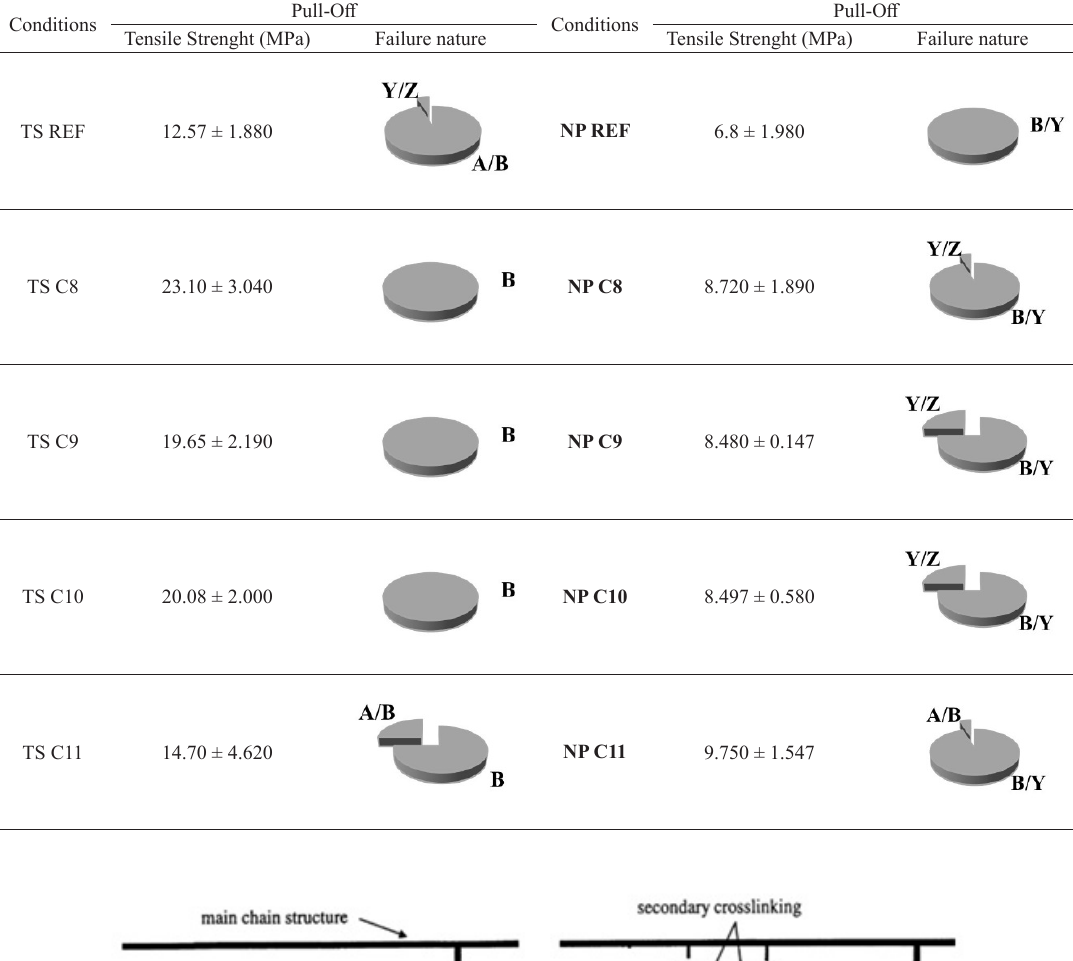
O based coatings applied by thermal spray (TS) and as epoxy-Nb 2 5